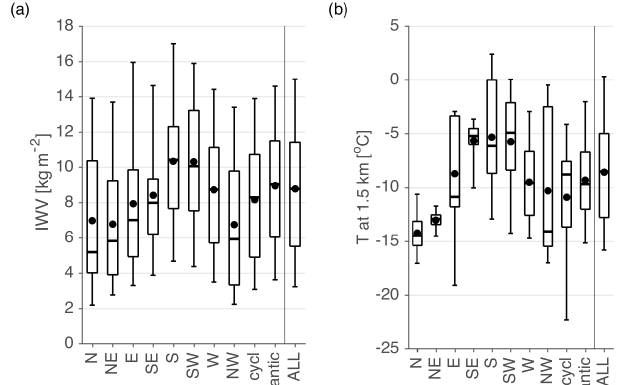
Figure 8. IWV (a) and 1.5km temperature (b) for time periods with P-MPC present for each weather type. Boxes and whiskers as in Fig. 7. The medians were found to differ on a 95% confidence